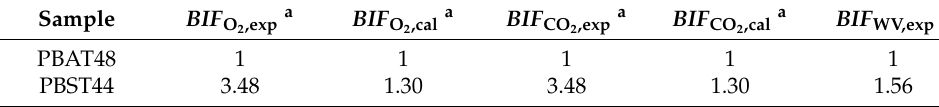
Table 4. Barrier improvement factors of PBST44 and PBAT48